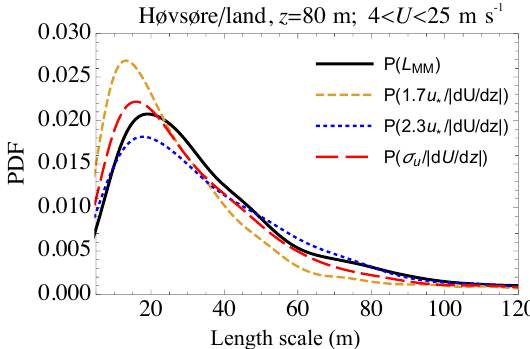
Figure 4. Probability density function of turbulent length scale from observations at Høvsøre from the homogeneous eastern land sectors. Black: Mann-model scale from fits to spectra; dot- ted/blue: “mixing-length” formulation ( (cid:96) m ∝ u ∗ / | d U/ d z | ) with re- vised constant; dashed/gold: Peña et al. (2010) form for (cid:96) m ; red/long-dashed: σ u / | d U/ d z | form